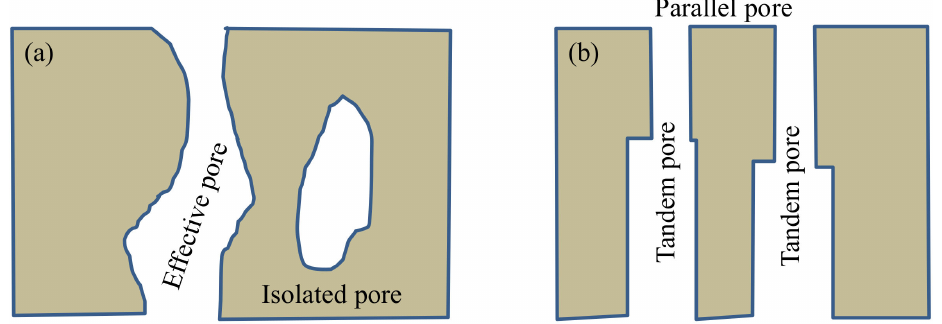
Figure 1. Diagram of coal pore type. ( a ) Schematic diagram of effective pores and isolated pores. ( b ) Classification of the effective